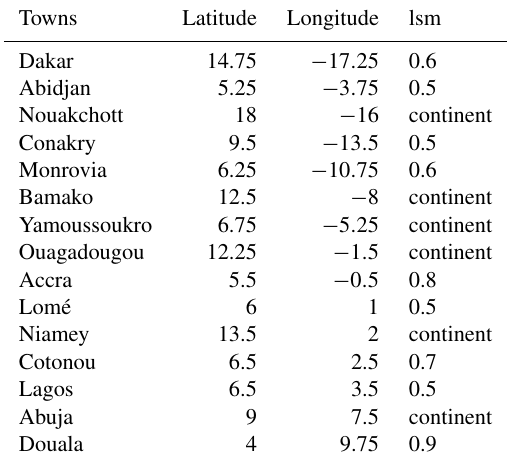
Table 1. Land sea mask (lsm) of West African towns used in this